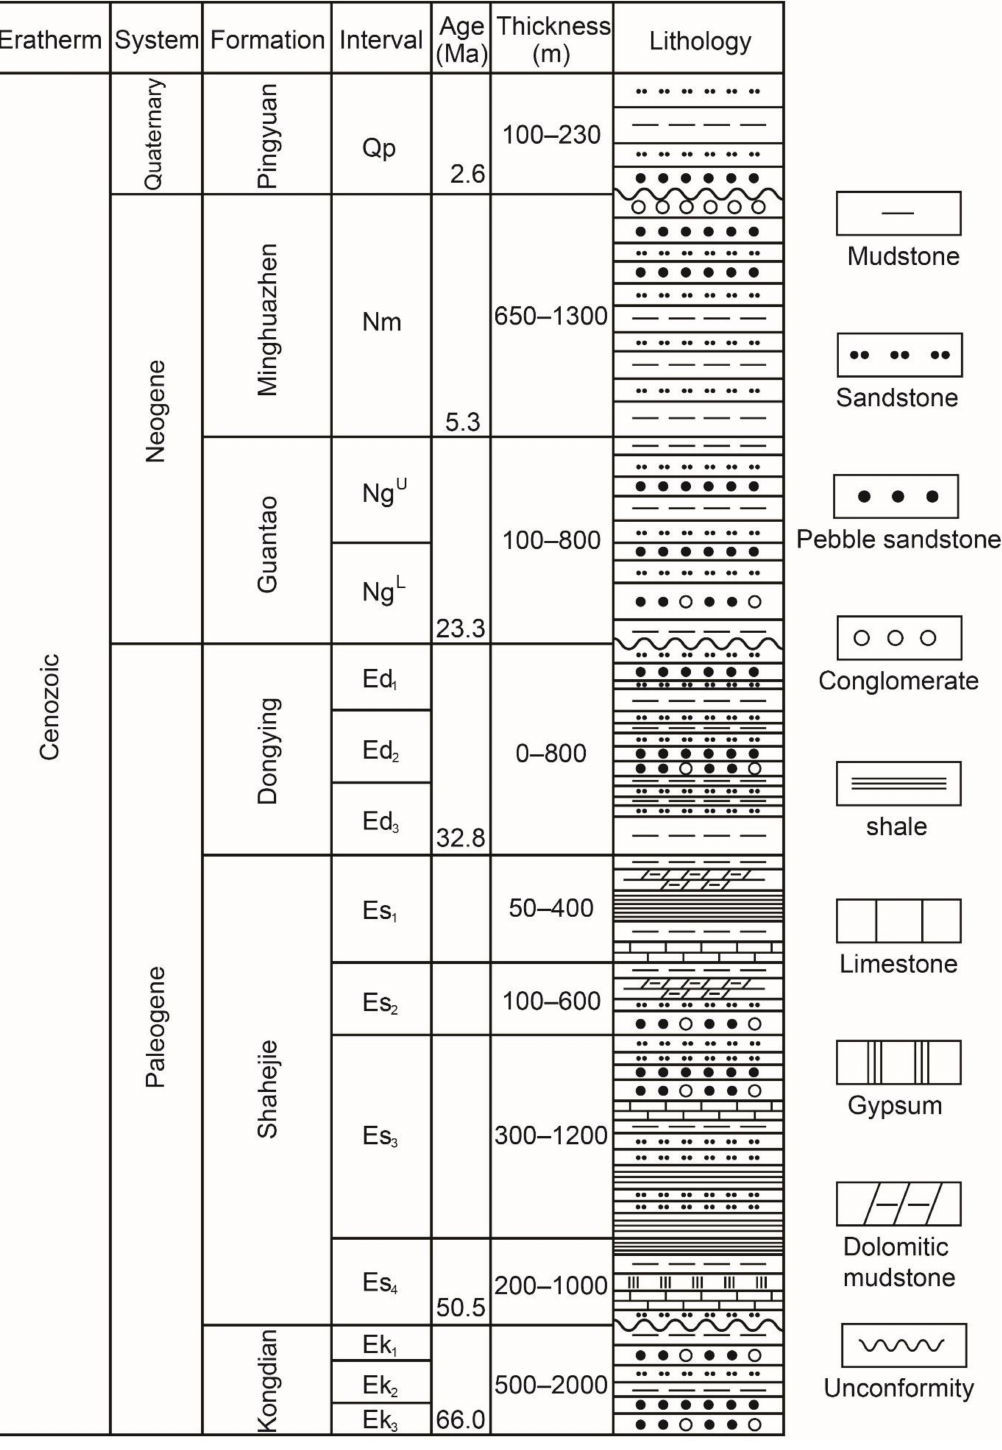
Figure 2. Stratigraphic sequence of the Chezhen depression in the Cenozoic. Modified from Zhang et al. (2019)